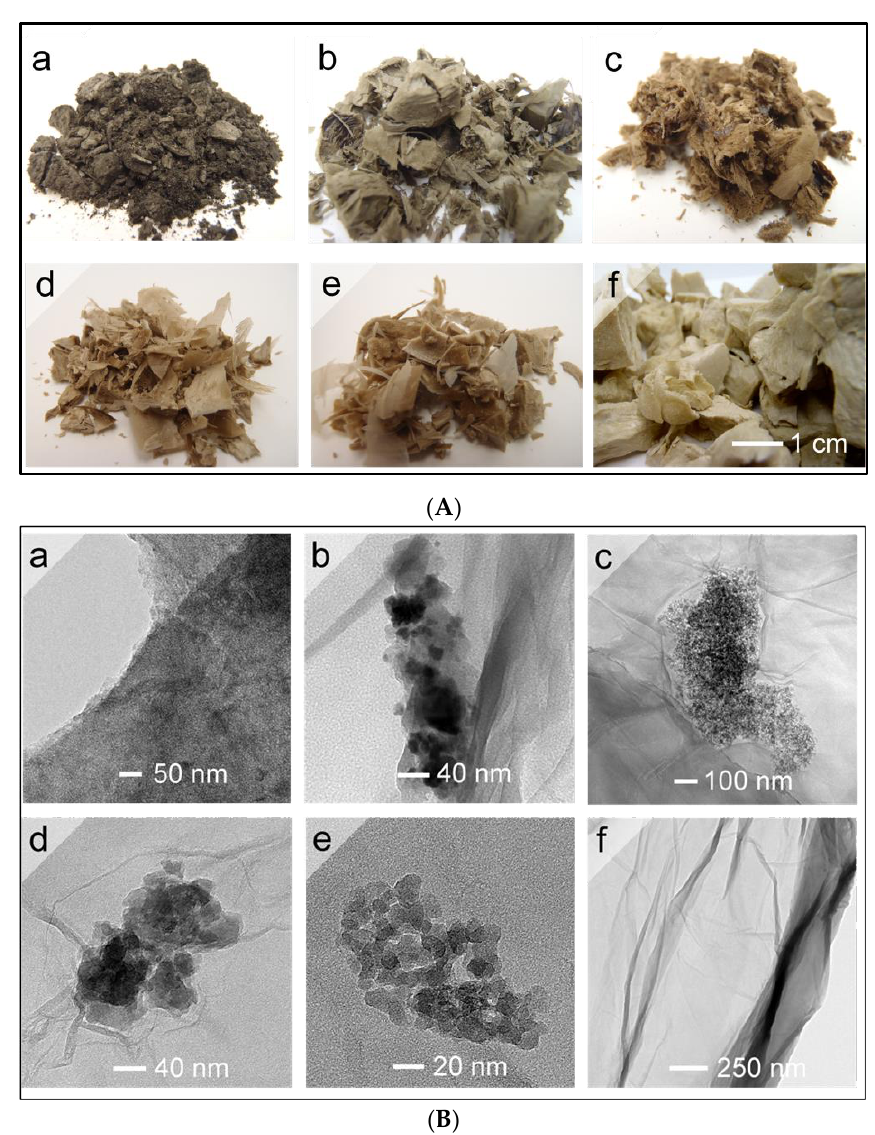
Figure 1. ( A ) Optical images; and ( B ) TEM images of: ( a ) GO-Sn; ( b ) GO-Fe; ( c ) GO-Zn; ( d ) GO-Al; ( e ) GO-Mg; and ( f ) GO materials.